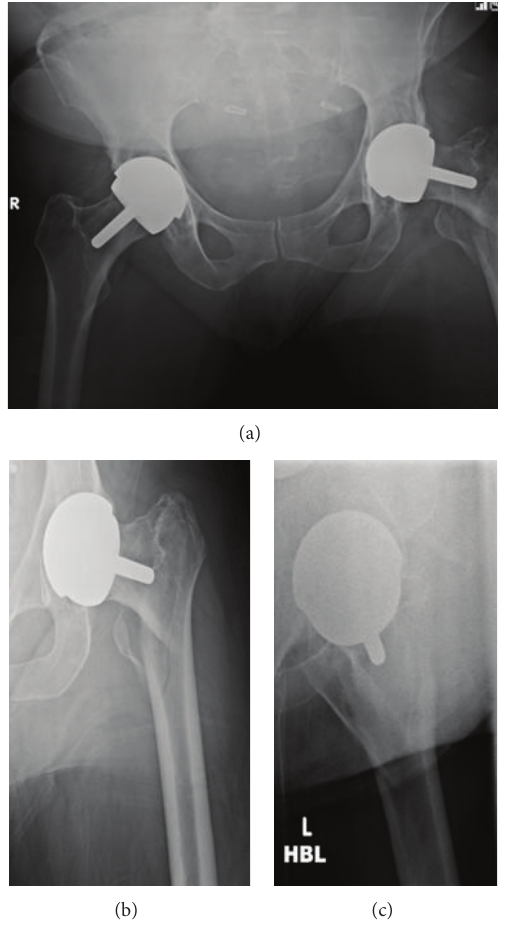
Figure 2: (a) and (b), AP views. (c) Lateral